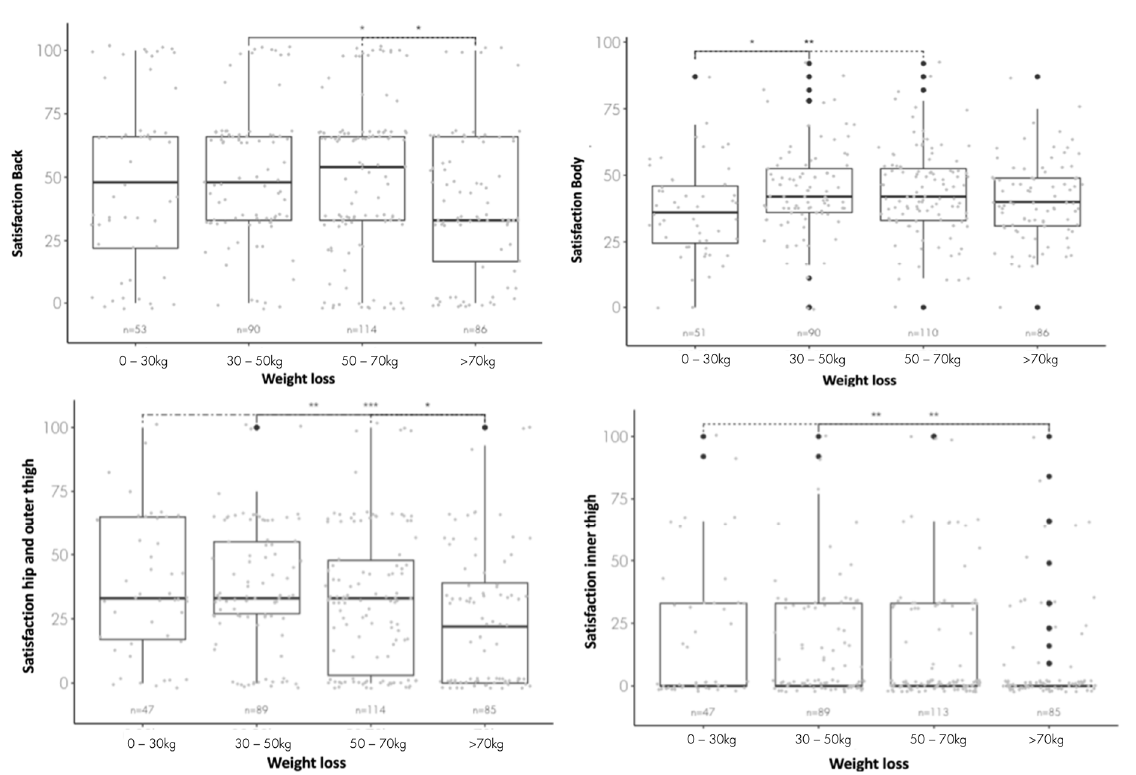
In the subcategory ZR, significant differences were found between B vs. D ( p = 0.062 *) and C vs. D ( p = 0.062 *) (Figure 3).